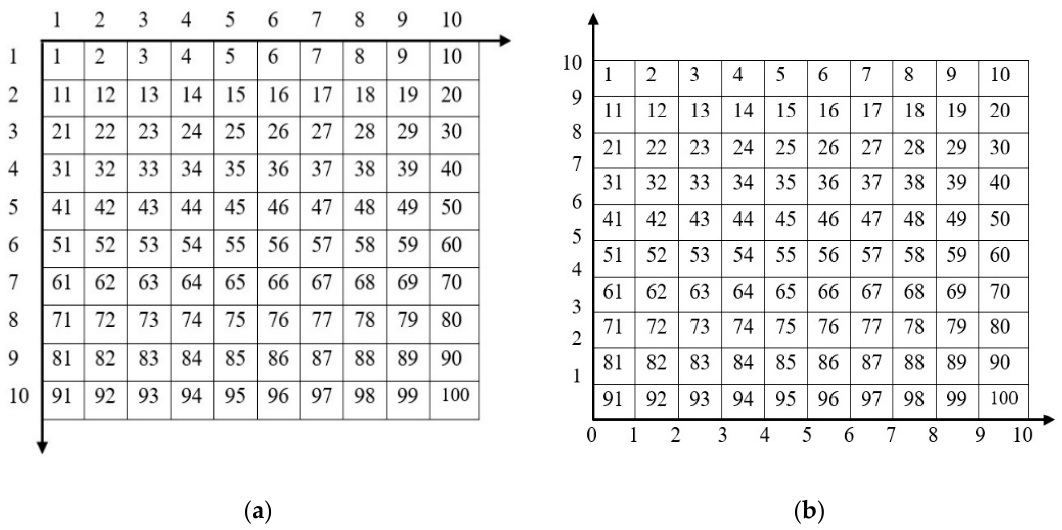
Figure 2. Correspondence identification types: ( a ) serial number to the grid; ( b ) serial number to (x, y) coordinates.